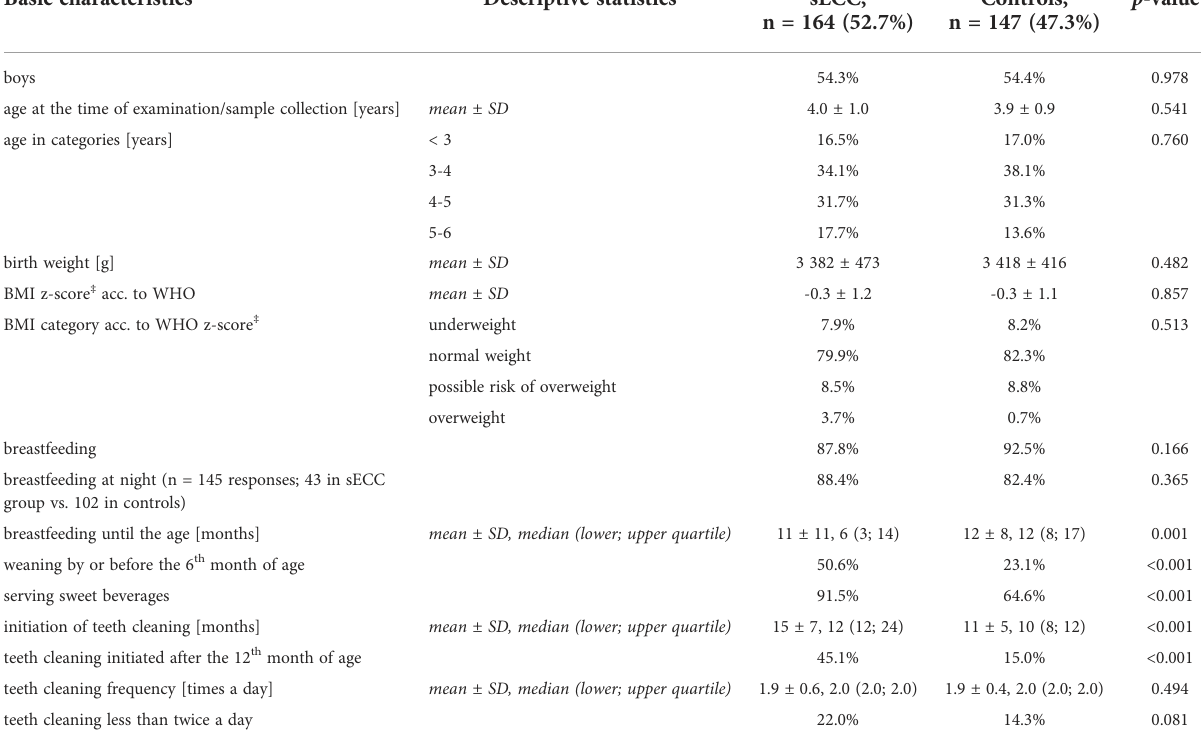
TABLE 1 Basic descriptive characteristics of children classi fi ed according to the oral status into cases (with sECC, dmft ≥ 6) and controls (dmft = 0). Basic